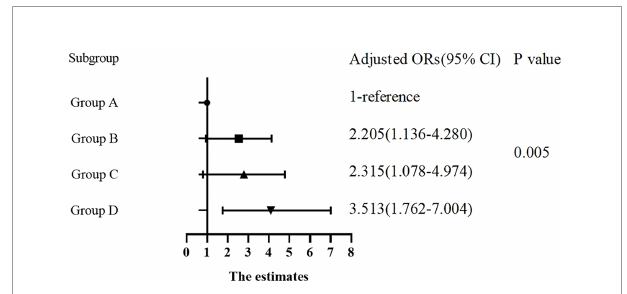
FIGURE 1 | Forest plot visualizing adjusted ORs based on logistic regression analysis.